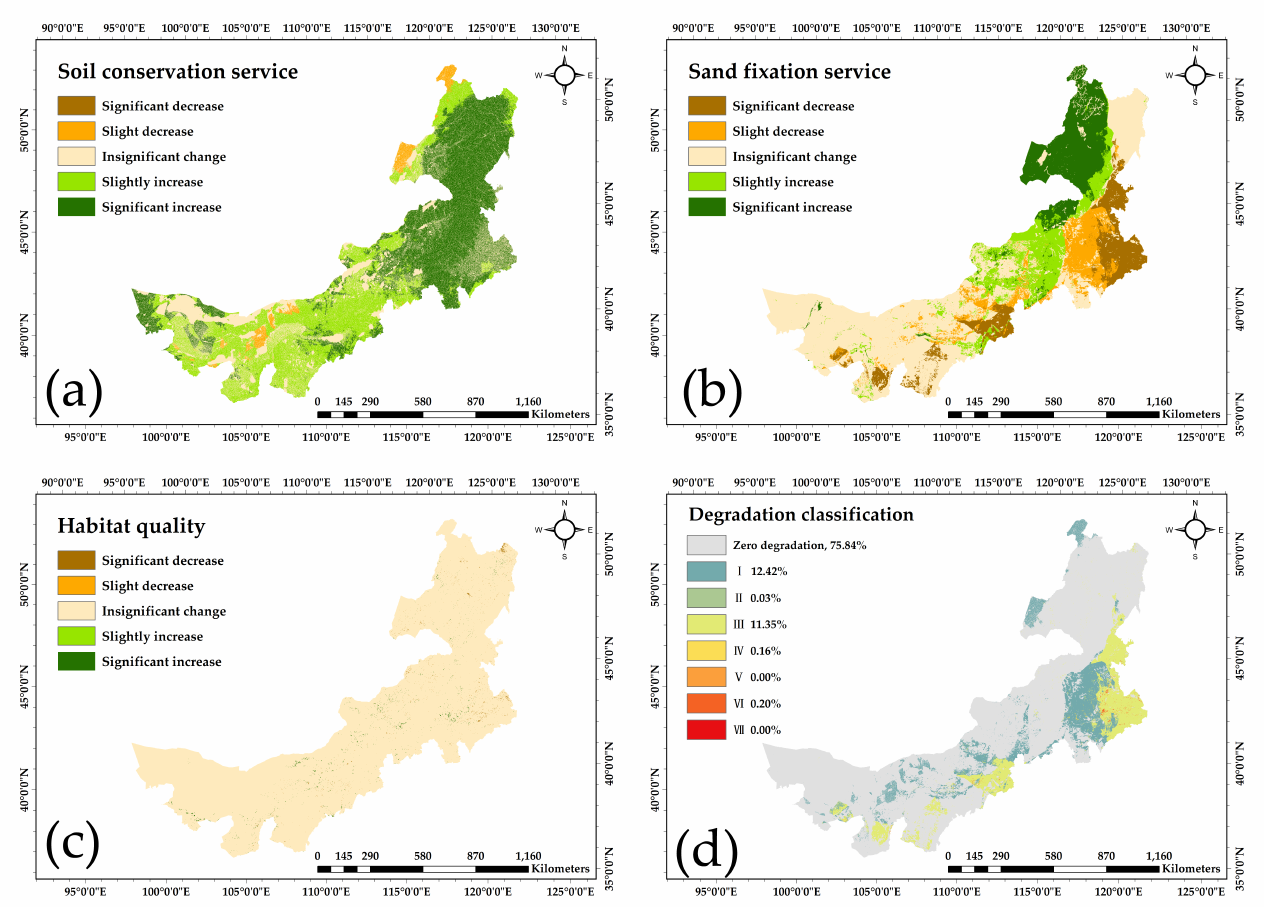
Figure 4. Ecosystem services change from 2000 to 2020: ( a ) soil conservation service; ( b ) sand fixation service; ( c ) habitat quality; and ( d ) degradation classification. For Figure 4d: one service is slightly degraded (I), two services are slightly degraded (II), one service is seriously degraded (III), one service is severely degraded and one service is slightly degraded (IV), one service is severely degraded and two services are slightly degraded (V), two services are seriously degraded (VI), three services are seriously degraded